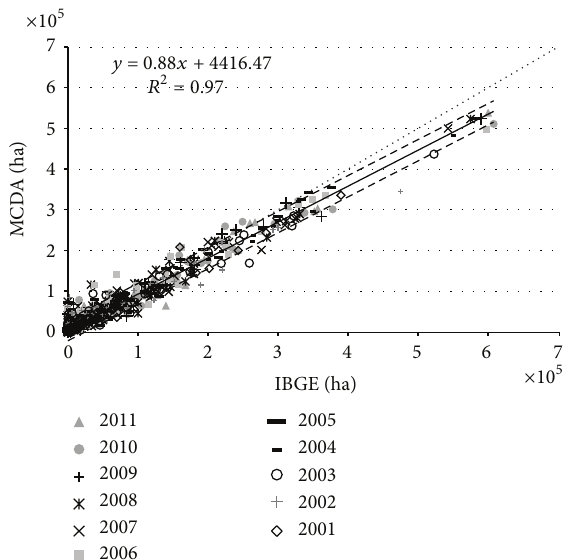
Figure 5: Regression analysis between soybean area estimates by MCDA (second forecast) and IBGE for the Mato Grosso State for all crop years (2000/2001 to